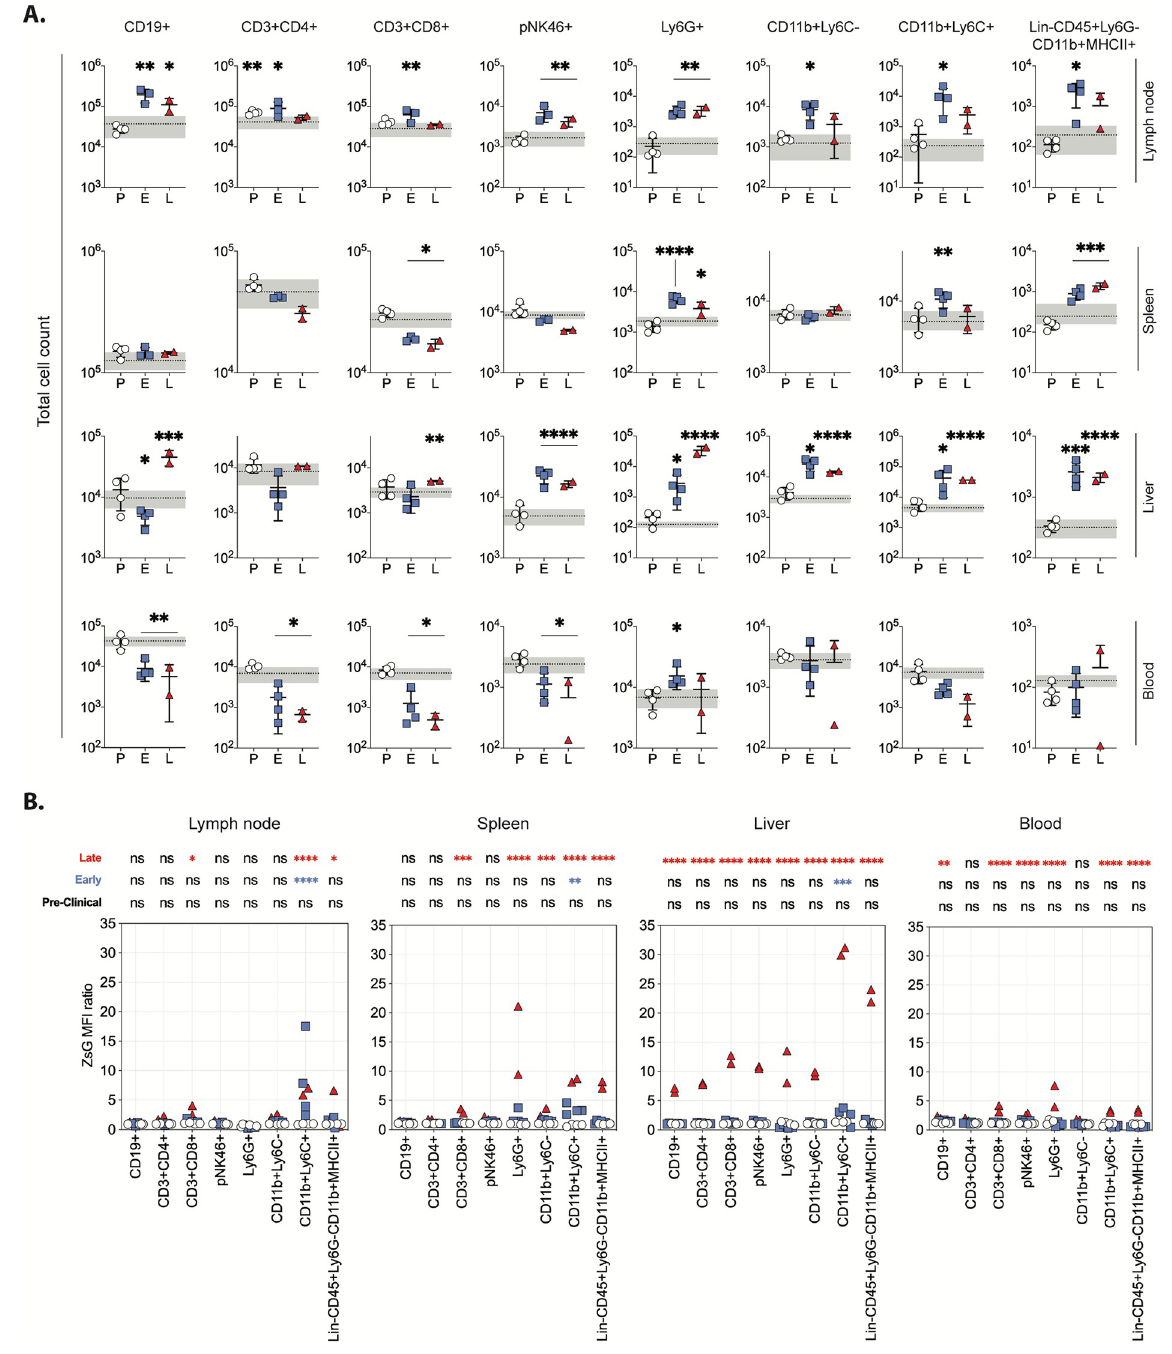
Fig 5. Cell population kinetics and susceptibility in mice infected with CCHFV/ZsG. (A) Differences in total absolute numbers of tissue- specific cells were determined for CCHFV/ZsG-infected mice classified as being in the pre-clinical (open circle; n = 4), early (blue square; n = 4), or late (red triangle; n = 2) stage of infection at time of euthanasia. Symbols represent individual animals, with error bars showing means and standard deviation. Dotted line represents the mean and the grey shading represents ± 1 SD from mock-infected control animals ( n = 6). (B) Graphs represent the ZsG mean fluorescent intensity (MFI) ratio of tissue-specific B cells (CD19+), T cells (CD3+CD4+ and CD3+CD8+), natural killer cells (NK; pNK46+), polymorphonuclear neutrophils (PMN; Ly6G+), immature monocytes/macrophages (CD11b+Ly6C-), activated monocyte/macrophages (CD11b+Ly6C+), and dendritic cells (DC; Lin-CD45+Ly6G-CD11b+MHCII+) over mock-infected controls ( n = 6) for CCHFV/ZsG-infected mice classified as being in the pre-clinical (open circle; n = 4), early (blue square; n = 4), or late (red triangle; n = 2) stage of infection at time of euthanasia. Symbols represent individual animals. For both panels, significant change from levels in control animals is represented (if not stated, the difference was not significant). � p < 0 . 05 , �� p < 0 . 01 , ��� p < 0 . 001 , ���� p < 0 . 0001 . Data were analyzed by multiple t-test, with individual values indicated in a scatter dot plot (means ± SD).